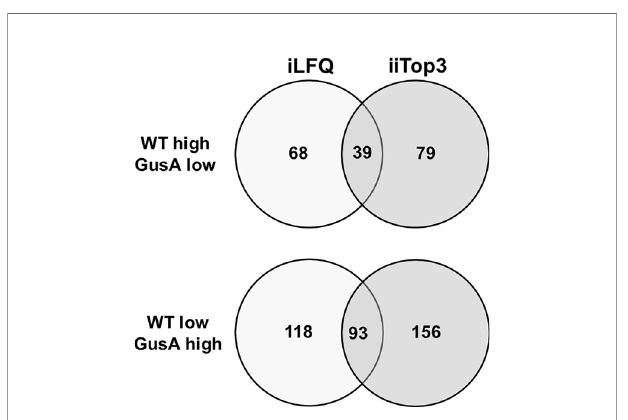
FIGURE 3 | Venn diagram depicting the number of differentially expressed proteins in transfected and untransfected G. lamblia trophozoites. Untransfected trophozoites (WT) and trophozoites transfected with E. coli glucuronidase A were subjected to MS shotgun analysis as described in Materials and Methods. The differential proteins were determined via the iLFQ, the iiTop3 algorithm or via both.